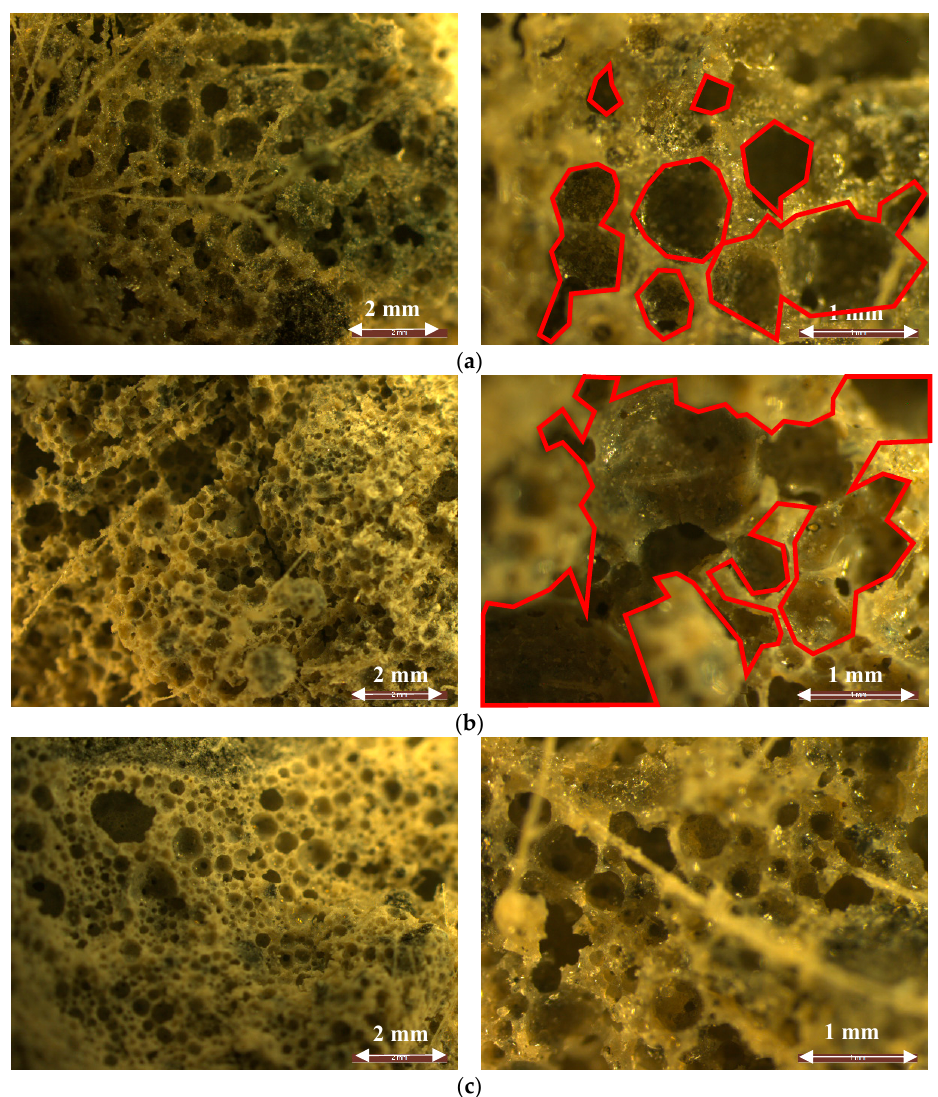
Figure 11. ( a ) Cross-section in X – Z direction; ( b ) cross-section in Y – Z direction; ( c ) three-dimensional (3D) segmentation of inner section.